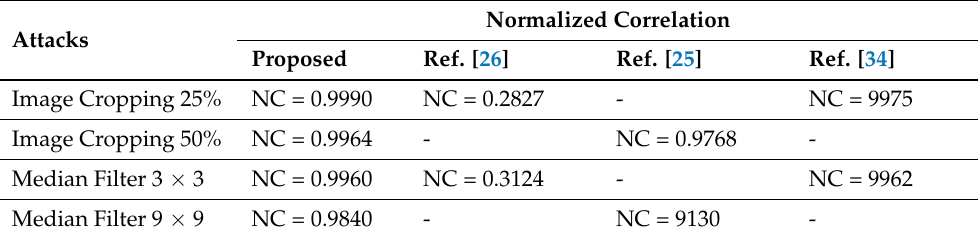
Table 10. Normalized correlation against image geometrical